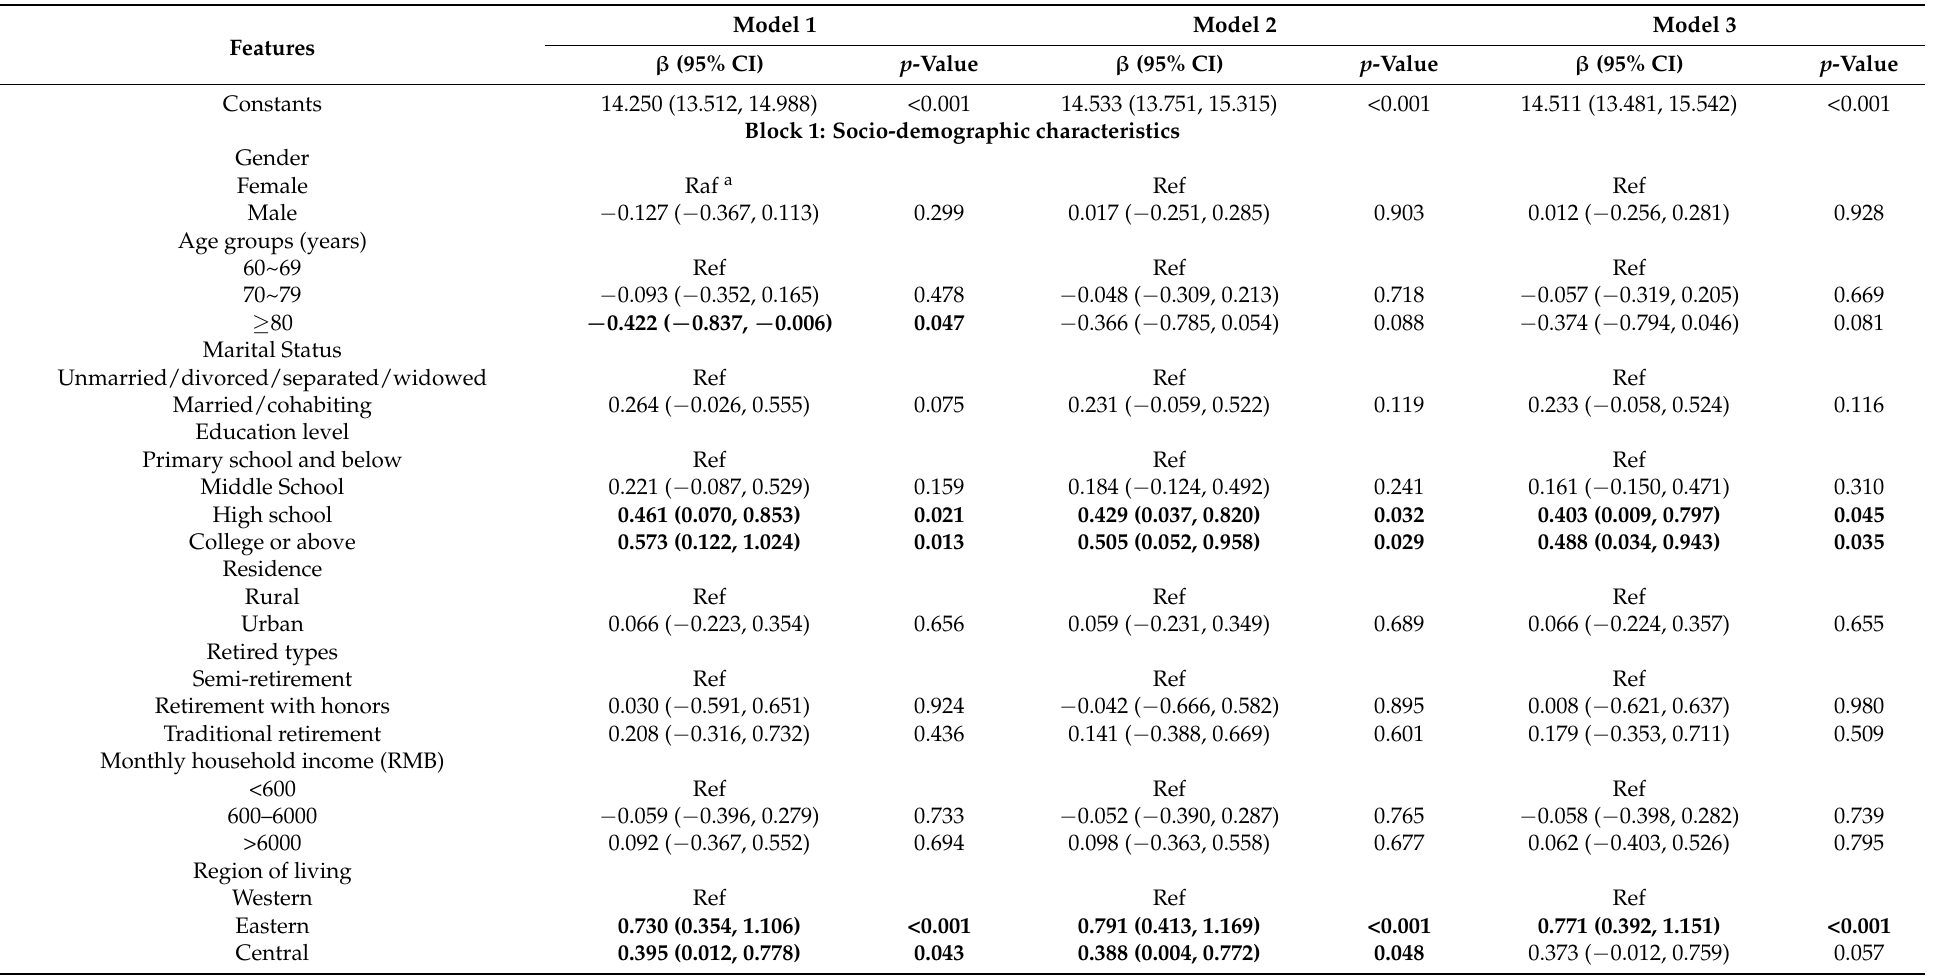
Table 3. Associated factors * impacted DHB among older Chinese during the COVID-19 pandemic ( n =